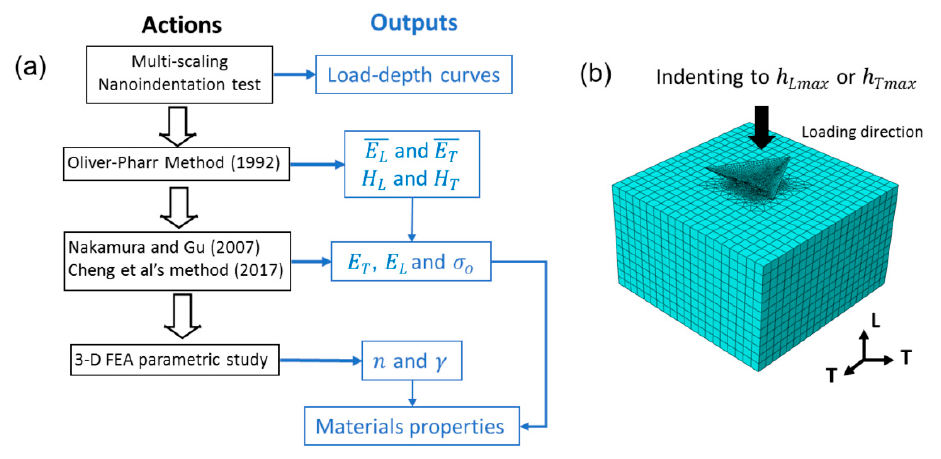
Figure 7. ( a ) The algorithm of inverse calculation and ( b ) the sketch of the FEA model with a Berkovich indenter.